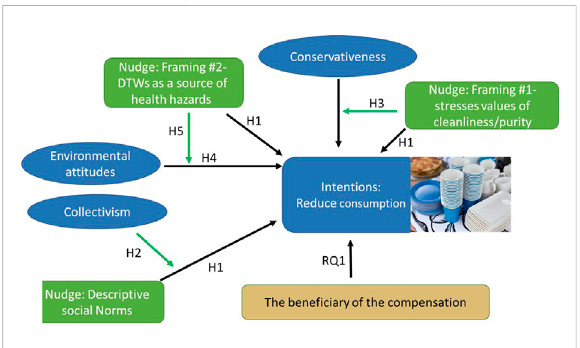
FIGURE 1 The hypothesized relationships between the Nudges and the moderating factors. The oval variables represent the latent constructs, dashed arrows represent mediating